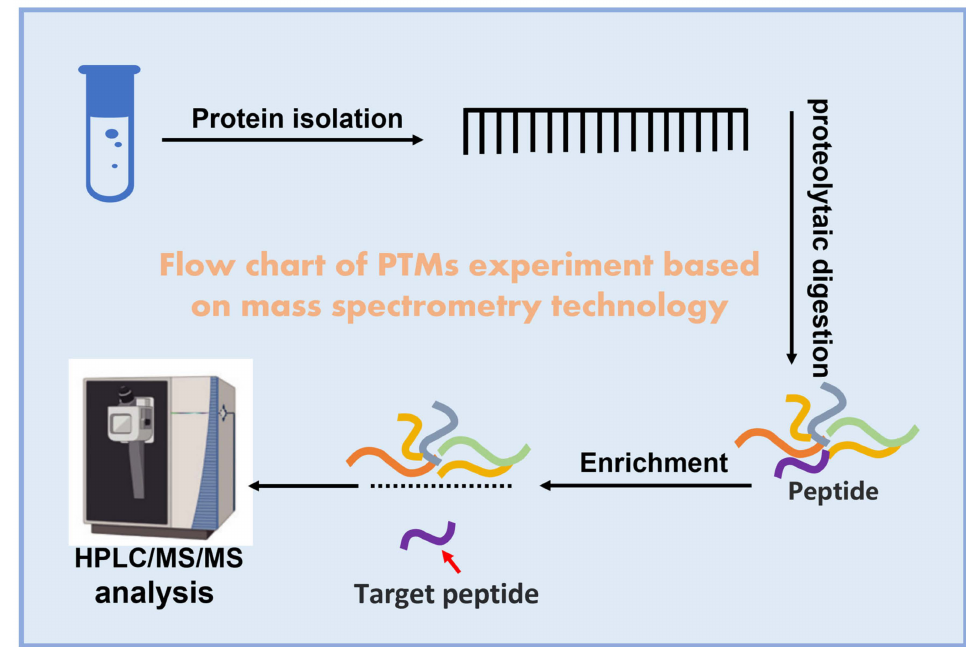
Figure 2. Diagram of experiments to detect posttranslational modifications: preparation of purified protein samples, digestion of proteins into peptides, enrichment of specific PTM peptides using appropriate methods, and HPLC/MS/MS analysis of specific enriched PTM